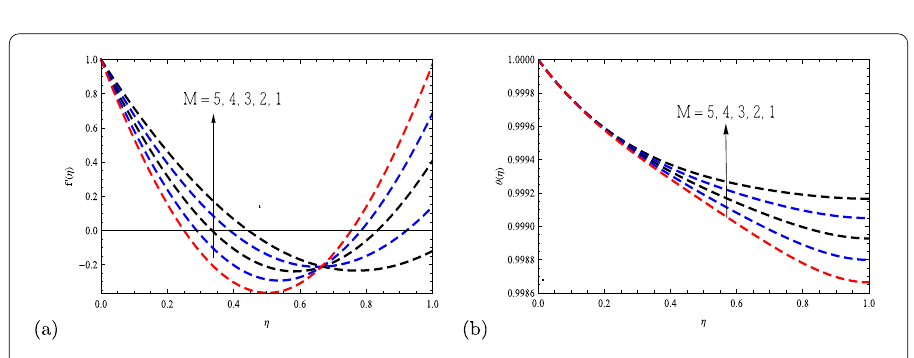
Figure 7 The effect of M on velocity profile and temperature profile with K = 0.1, Ma = 5, ϒ = 0.027013, Pr = 0.2, Gr = 5, S =